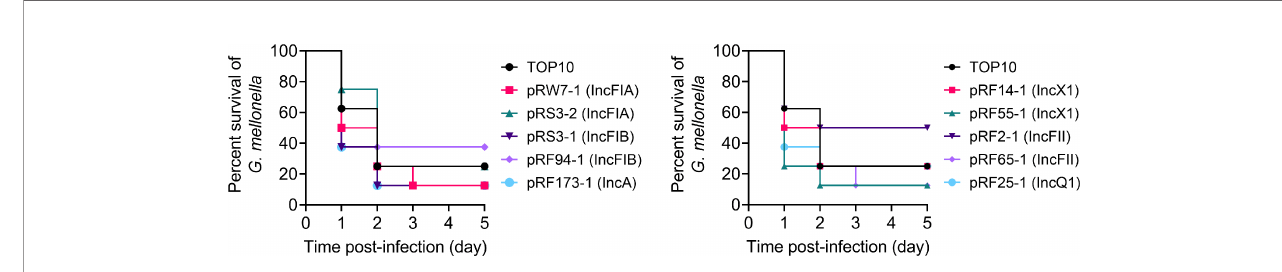
FIGURE 4 | Survival of G. mellonella larvae after infection with E. coli TOP10 and transformants carrying different types of tet (X4)-positive plasmids after 5